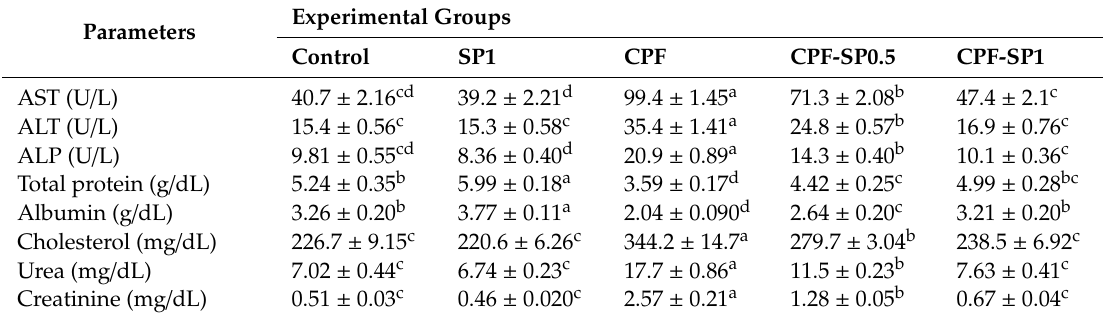
Table 2. Blood biochemical parameters in the examined groups